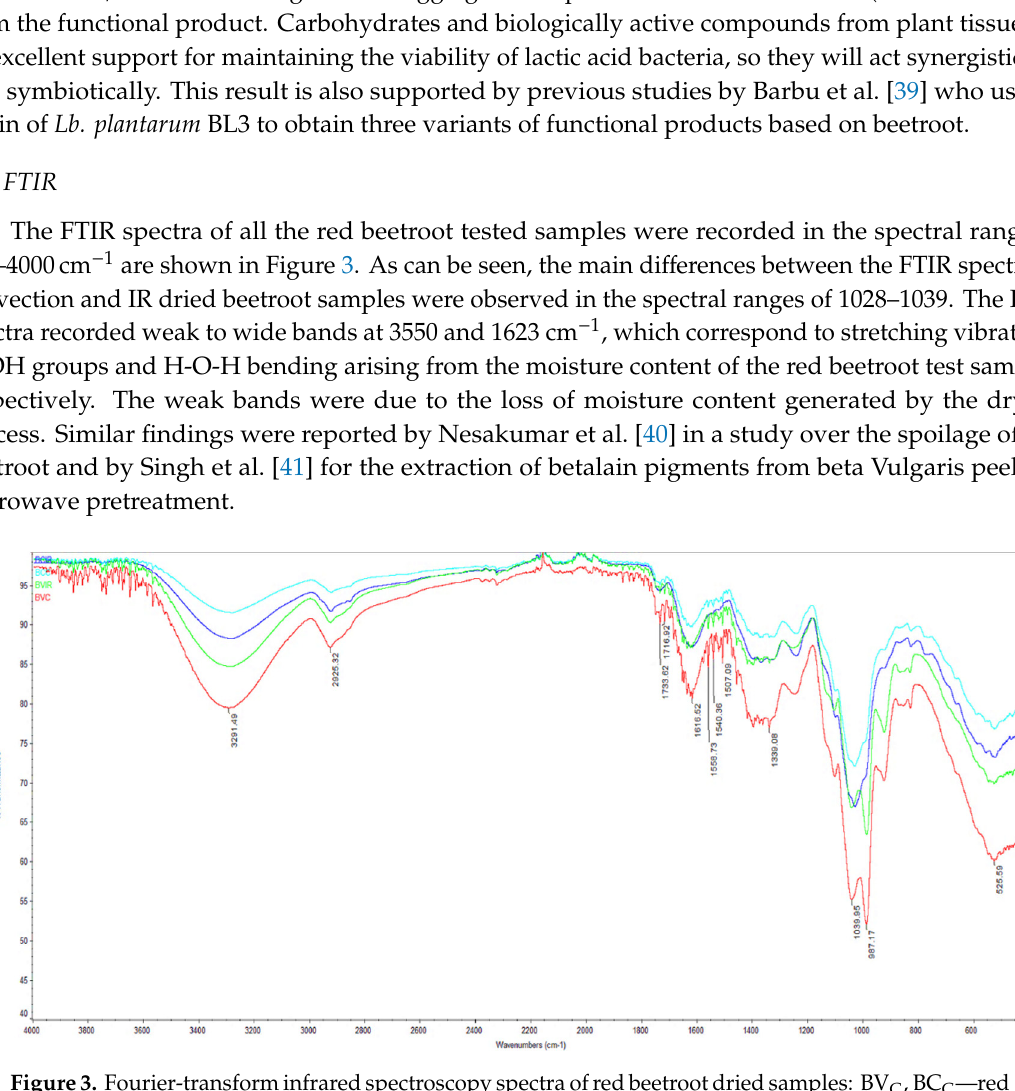
Table 2. Effects of drying treatment on color parameters of fresh and dried red beetroot purées. Color Parameters